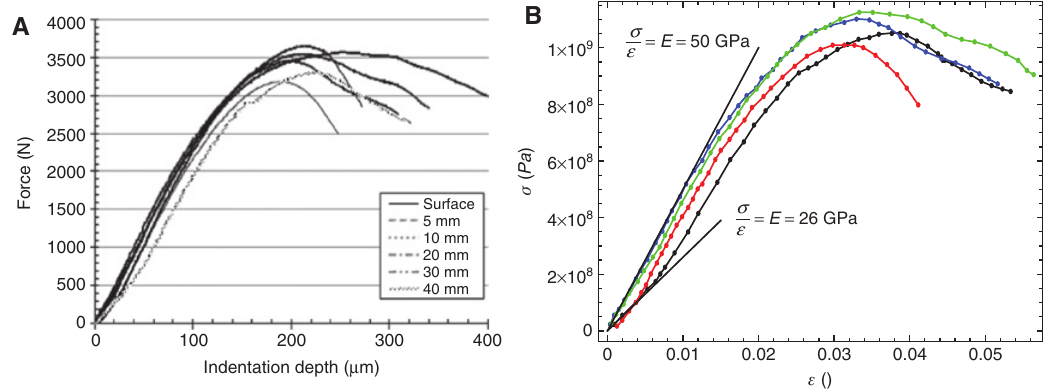
Figure 5: (A) Force vs. indentation depth by macroindentation experiments [6] on Dionysos marble. (B) Corresponding stress vs. strain curve using Eqs.